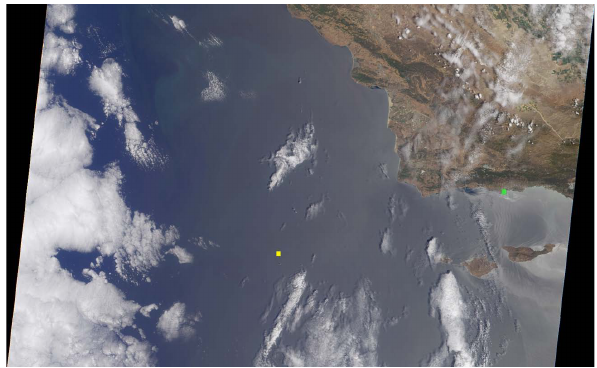
Fig. 7. MISR nadir image (Orbit 66950, Path 43) of an area off the coast of Southern California, acquired on 19 July 2012 at 11:58PDT (18:58UTC). The imaged area is about 380km wide. The yellow marker below image center shows the location of an AirMSPI 21- angle image sequence acquired shortly after the MISR overpass. The green marker on the coast near the right-hand edge of the image shows the location of the UCSB AERONET site. Fig. 8. AirMSPI nadir intensity image of the location marked in